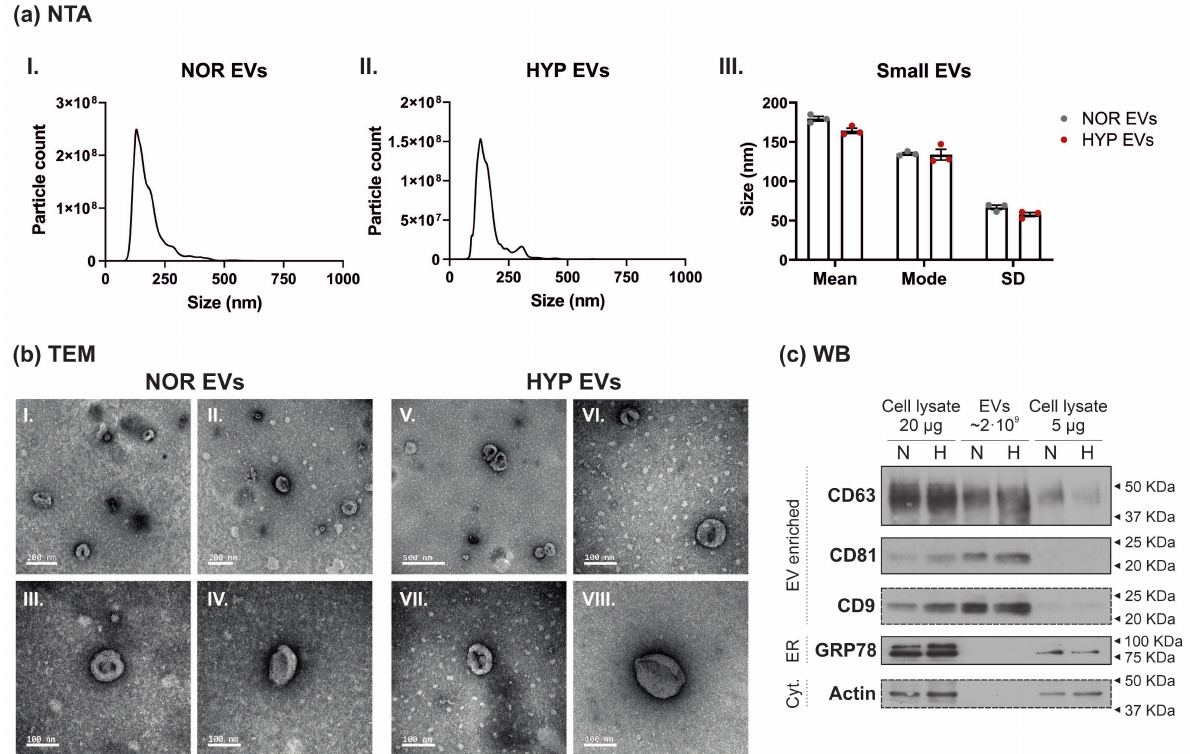
Figure 1. Characterisation of EVs from NOR and HYP hUCMSCs. ( a ) Nanoparticle Tracking Analysis (NTA) of small extracellular vesicles obtained from the conditioned medium of human umbilical cord-derived mesenchymal stromal cells (hUCMSCs) via differential ultracentrifugation following 24 h in culture under normoxic (NOR, ( aI. )) or hypoxic (1% O2—HYP, ( aII. )) conditions. ( aI. , aII. ) graphs show size distribution of the isolated EVs, and ( aIII. ) compares the three EV param- eters obtained via NTA, showing no differences in size distribution among EVs from both culture conditions. Samples were measured in triplicate. ( b ) Transmission Electron Microscopy (TEM) images obtained from NOR/HYP hUCMSC-derived EVs confirming the presence of cup-shaped spheres within the size range expected for the EV population studied. Scale bars: I. and II. = 200 nm; III., IV., VI., VII., VIII. = 100 nm; and V. = 500 nm. ( c ) Western Blot (WB) confirming the presence of proteins widely considered to be enriched in small EVs (the 3 classical tetraspanins: CD63, CD81 and CD9) and the lack of other cell/organelle specific proteins (the cytoskeletal protein actin and the ER protein GRP78) demonstrating high enrichment of EVs following dUC isolation protocol. Dashed lines indicate proteins blotted after membrane stripping. N = normoxia, H = hypoxia, ER = endoplasmic reticulum, Cyt. =